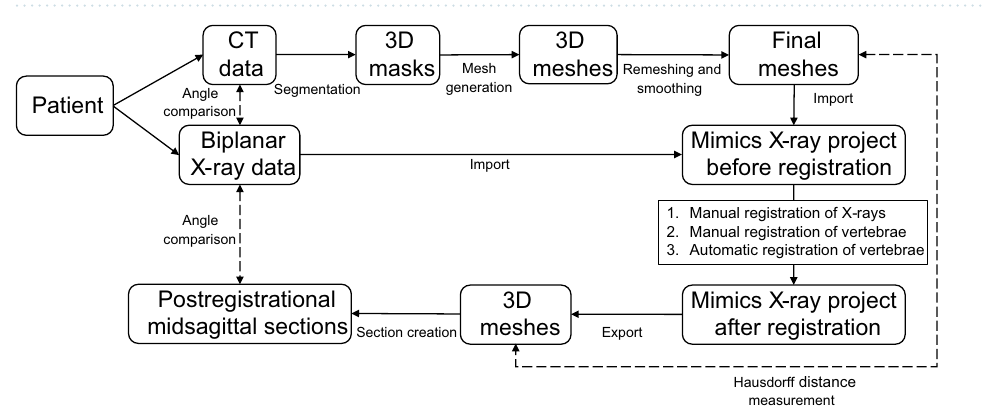
Figure 5. Spatial distribution of the distance of identical meshes between independent registrations. ( a and c ) 3D views of lumbar spine geometry registered by I 1 and I 2 respectively. ( b ) 3D heatmap of the spatial distribution of distances between the two meshes.